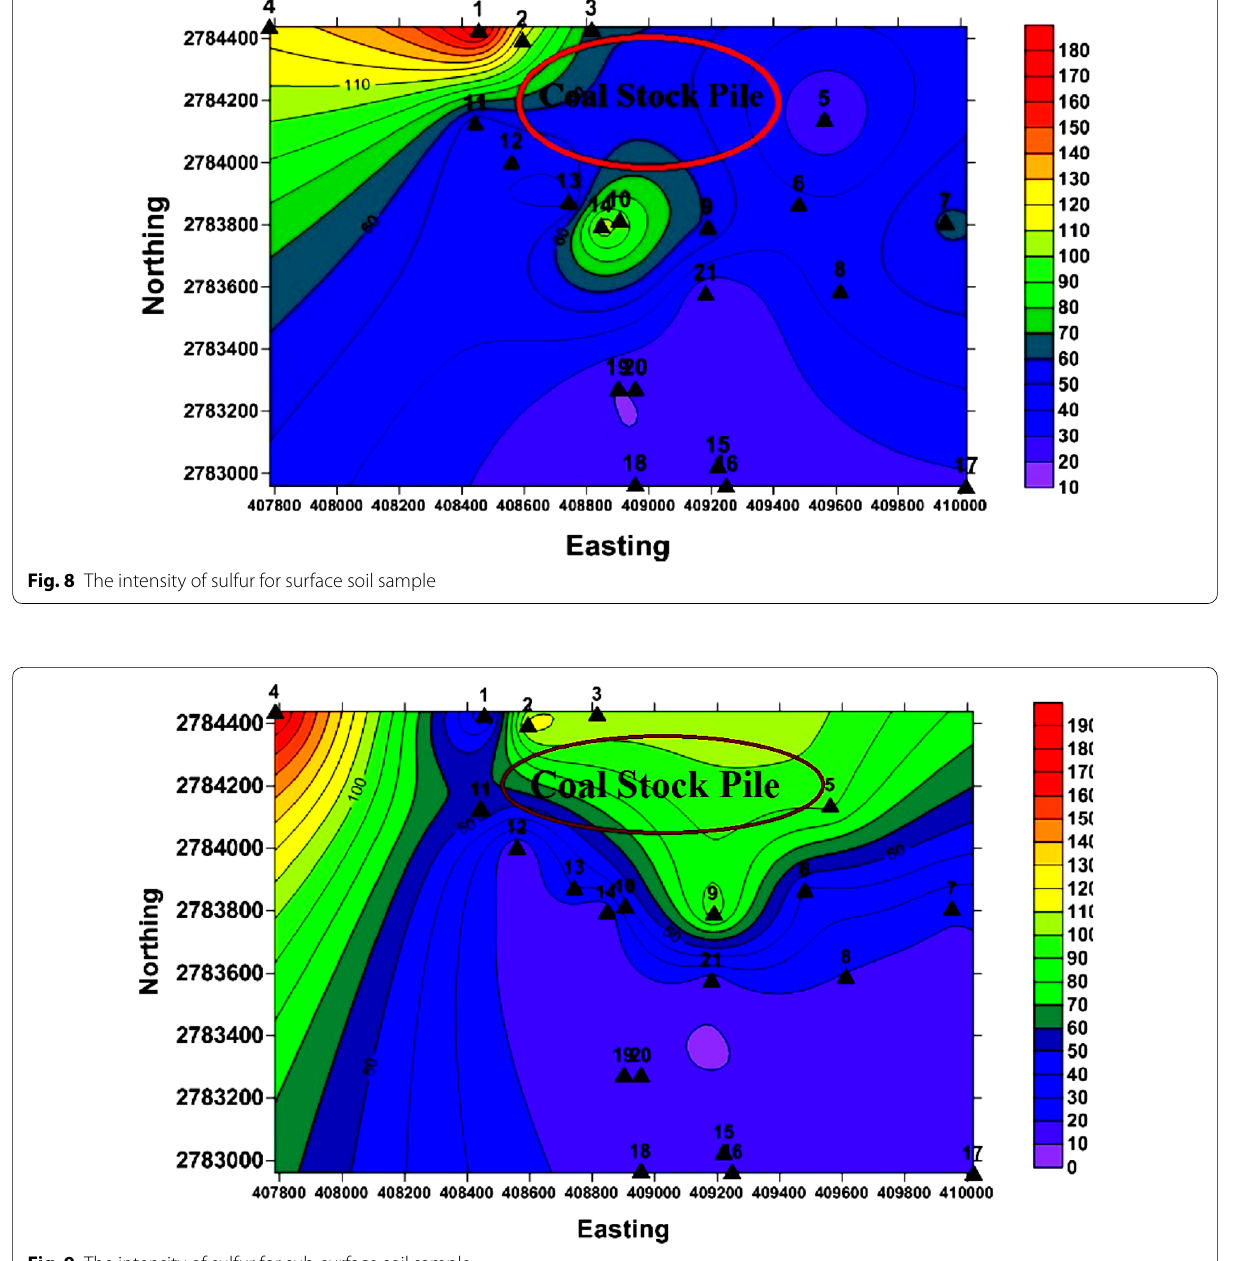
Fig. 9 The intensity of sulfur for sub-surface soil